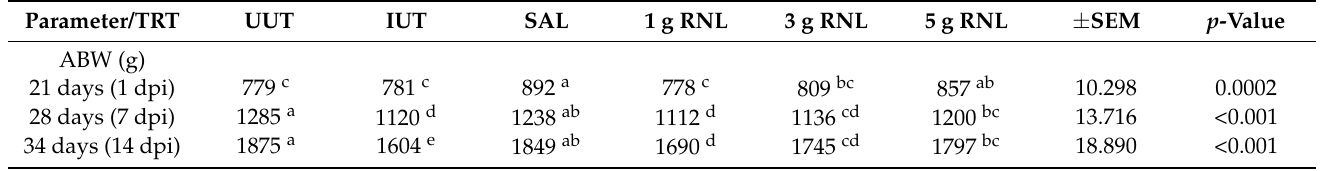
Table 2. Live body weight (BW), live body gain (BWG), cumulative feed intake (FI), feed conversion ratio (FCR), performance index (PI), and production efficiency factor (PEF) of birds with experimental diets during 1–14 dpi.